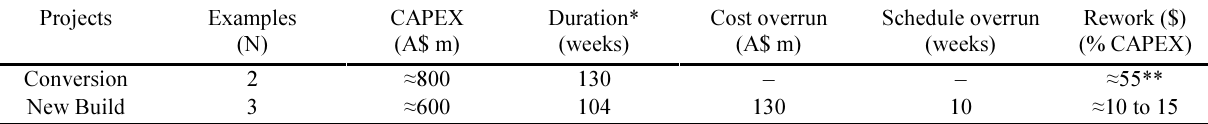
Table 3. FPSO project details